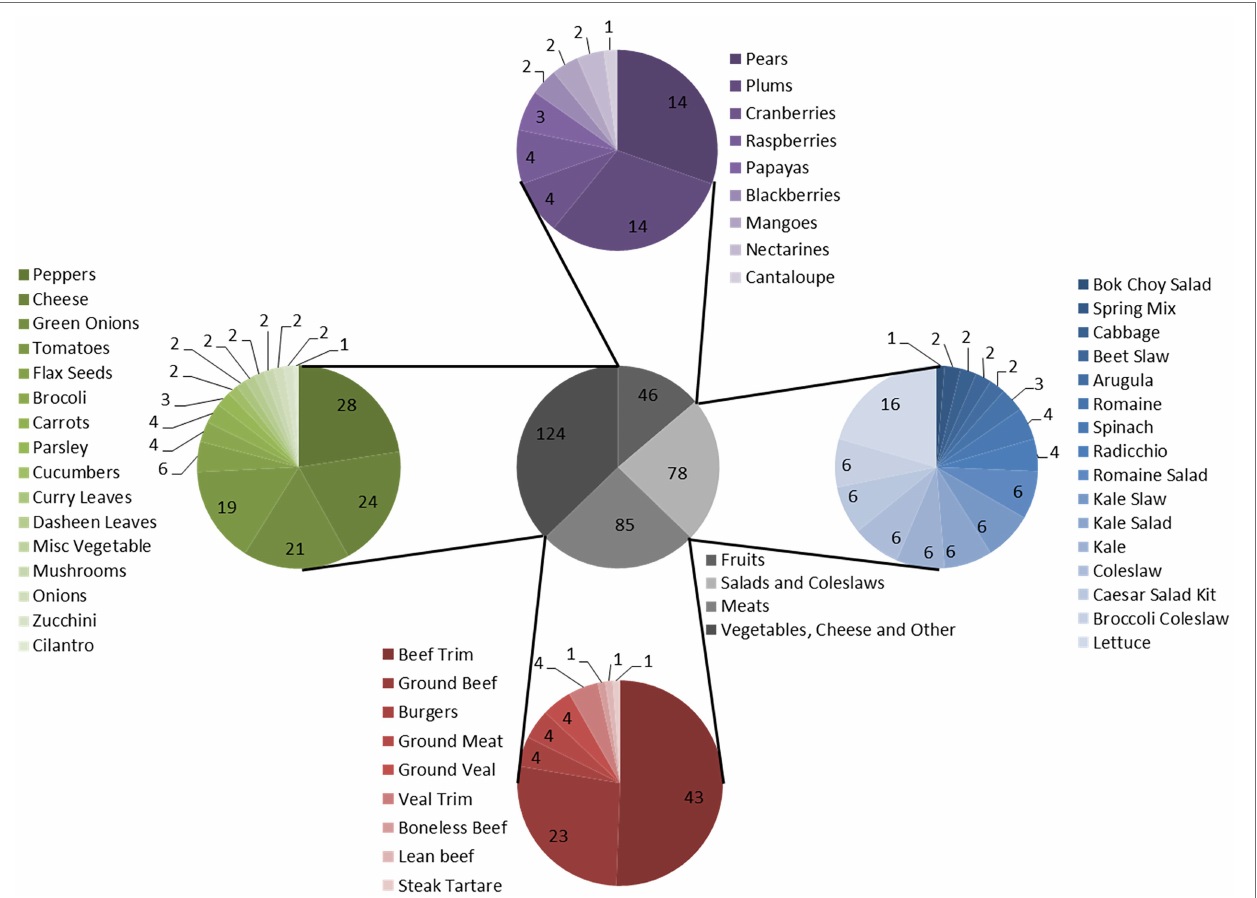
FIGURE 4 | Food product enrichment cultures tested for production of inhibitors. Gray pie chart: Categories. Blue pie chart: Salads and Coleslaws. Red pie chart: Meats. Green pie chart: Vegetables, Cheese, and Other. Purple pie chart: Fruits. Total food enrichment samples tested was 332